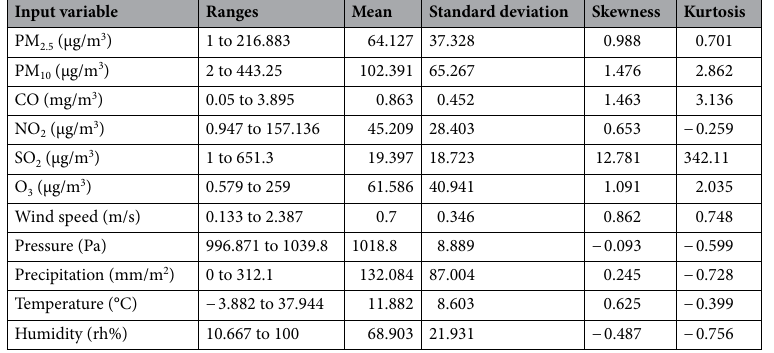
Table 1. Descriptive statistics of pollutant concentrations and meteorological parameters measured by national control point and self-built point after